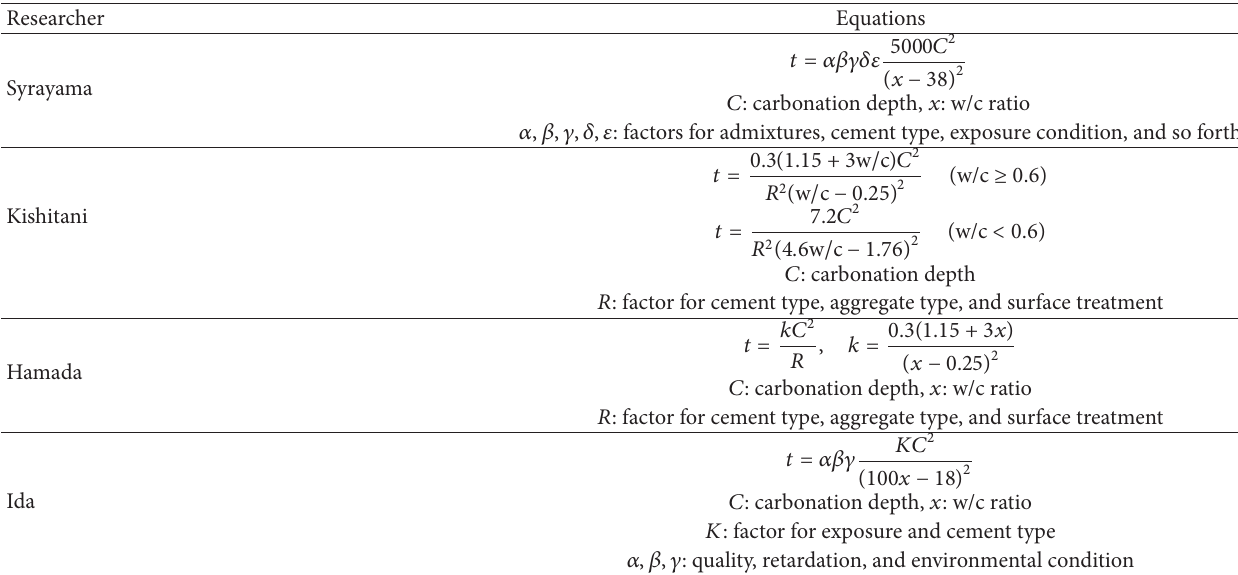
Table 2: Semiempirical equations for carbonation